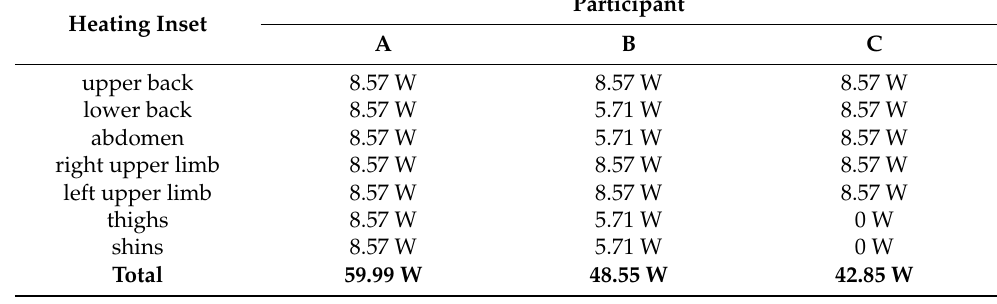
Table 4. Experimental results of heating power.